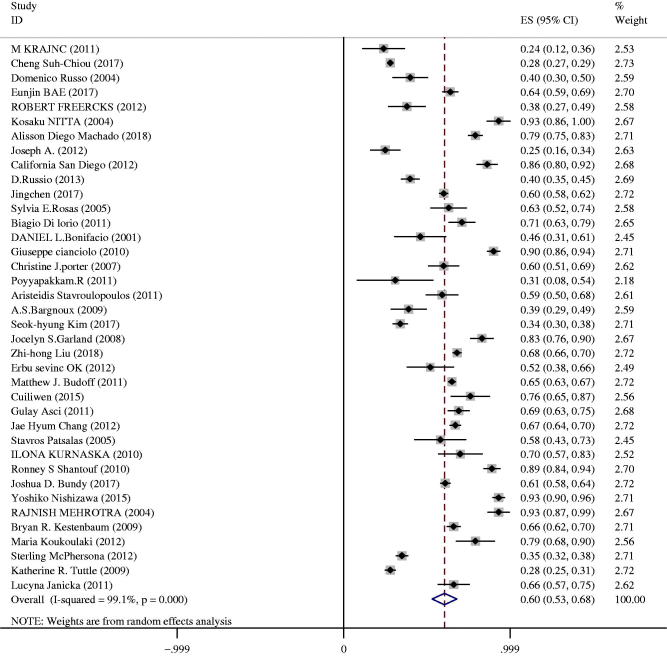
Forest plot of prevalence estimates of CAC in CKD patients.